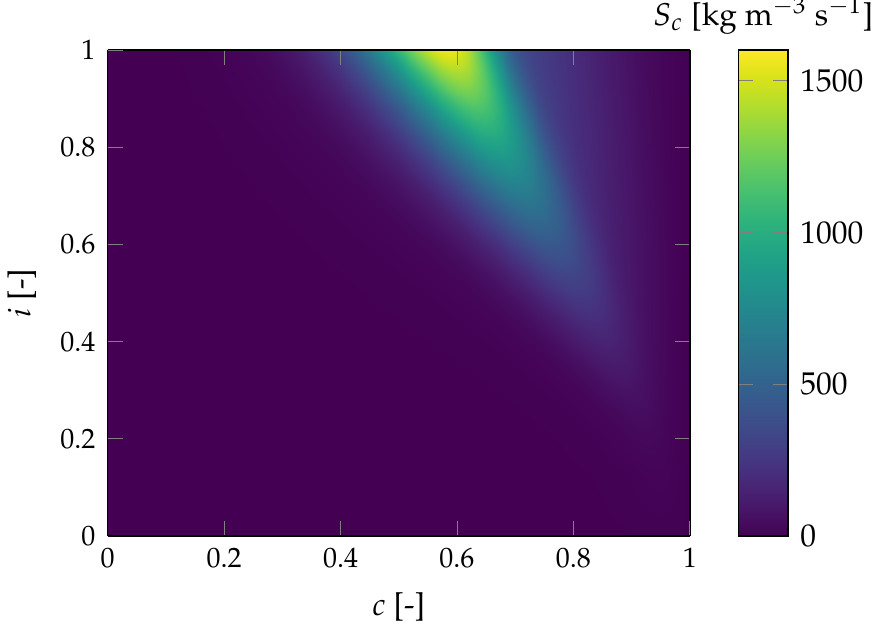
Figure 1. Reaction Progress Varialbe (RPV) source term as a function the RPV mean and en- thalpy